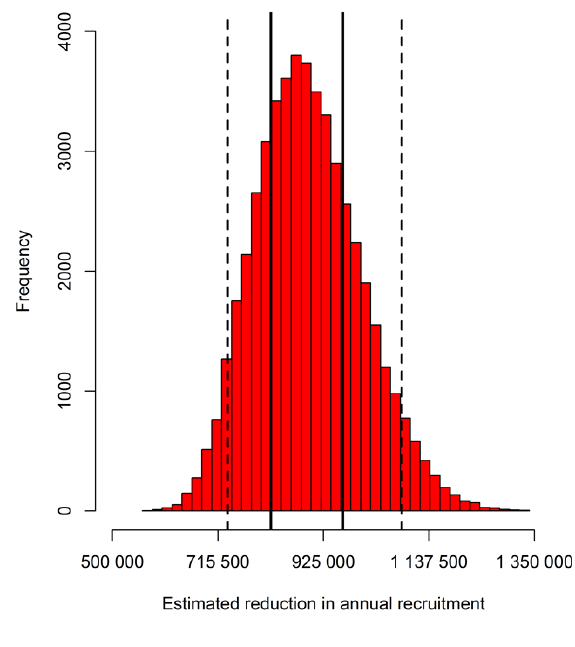
Fig. 2 . Distribution of estimated reduction in potential recruitment into the migratory bird population owing to forestry operations conducted during the breeding season. Solid vertical lines encompass inner 50% of the distribution, whereas dashed lines encompass 90% of the distribution. Estimates were generated from 50,000 Monte Carlo simulations including estimates of annual area disturbed, proportion of disturbances occurring during the breeding season, and estimated nest densities, plus demographic parameters derived from the literature (see